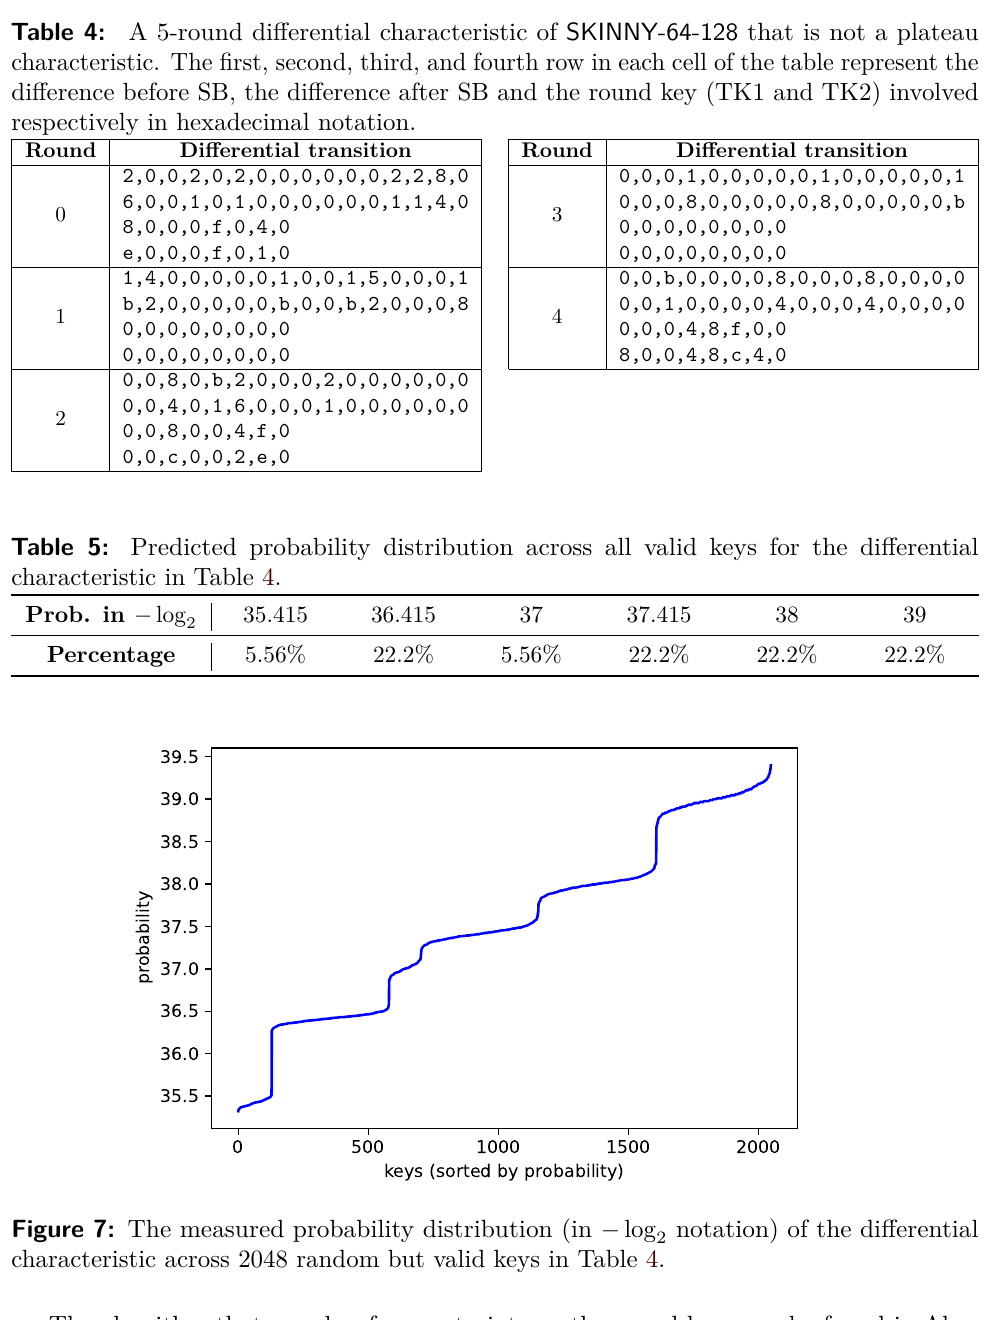
Figure 7: The measured probability distribution (in − log characteristic across 2048 random but valid keys in Table